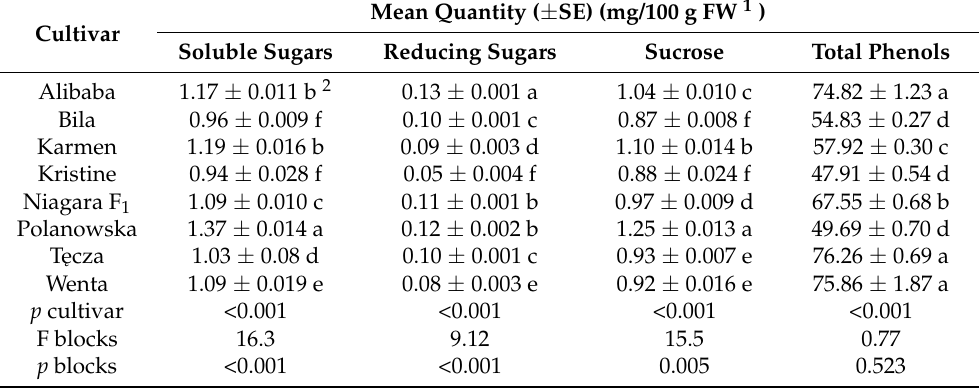
Table 4. The contents of sugars and total phenols in the not damaged by Thrips tabaci leaves of the tested onion cultivars in 2016, df =